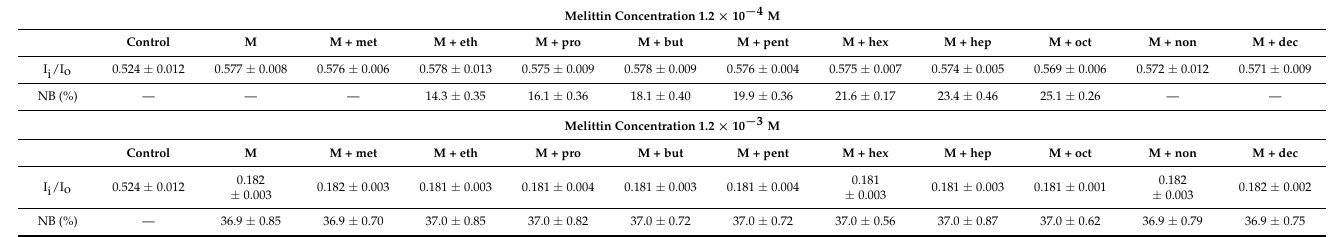
Table 1. Increase in membrane permeability to Fe(CN) 63 − ions and the formation of non-bilayer organized PC in the membranes of sonicated unilamellar liposomes treated with melittin and alcohols. The phospholipid composition of liposomes closely resembled that of the IMM in eukaryotes.